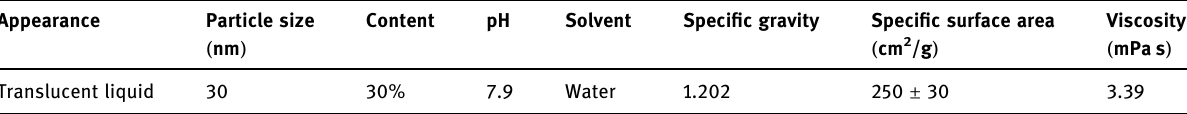
Table 1: Properties of NS sol